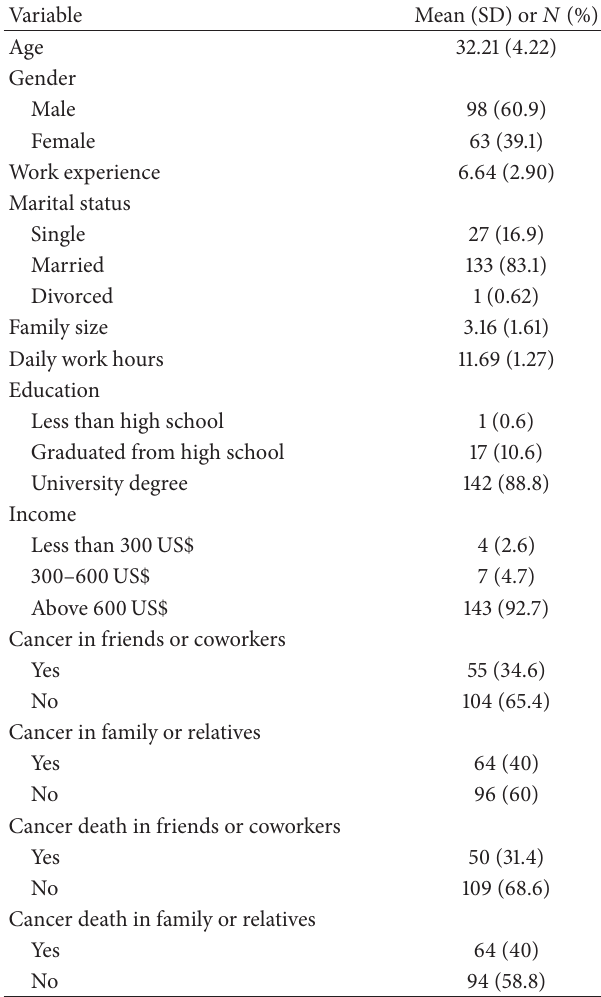
Table 2: Sample characteristics ( 𝑁 = 161 ) (missing are excluded from